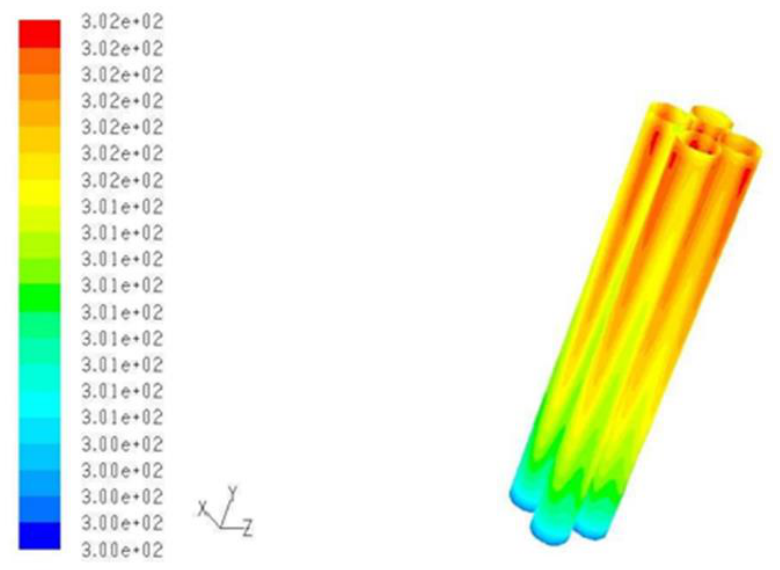
Figure 8. Surface temperature distribution in sub-channel square model.